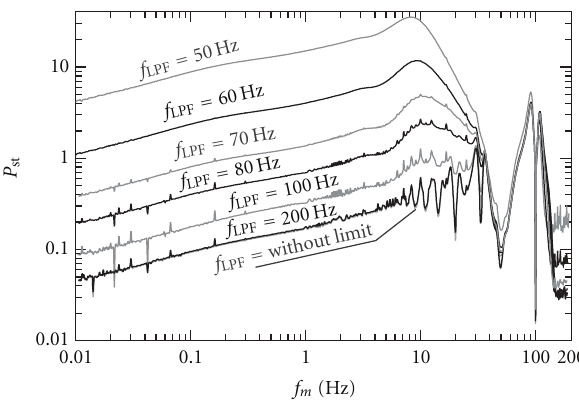
Figure 12: P st = f ( f m , f LPF , Δ f FM = 1Hz) characteristic for the case of FM with rectangular signal.